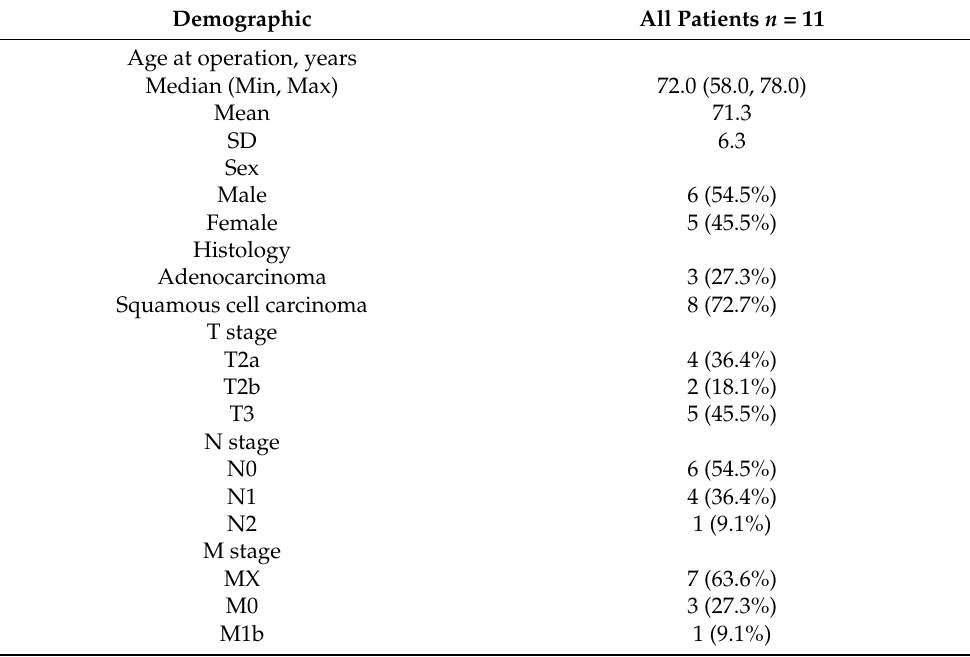
Table 1. Demographics of patients corresponding to samples included in explant